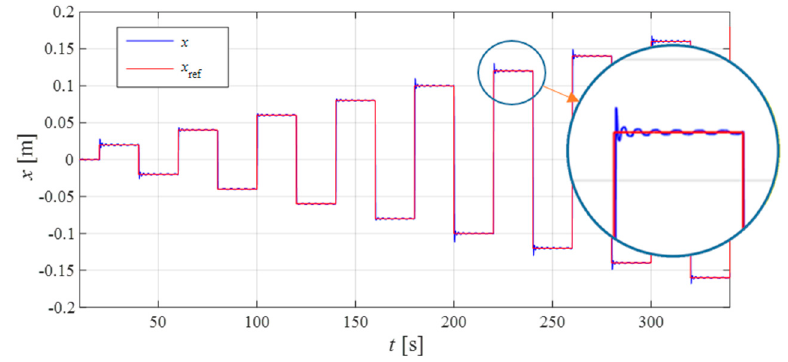
Figure 6. SFCI controller positioning test results: position vs. reference.